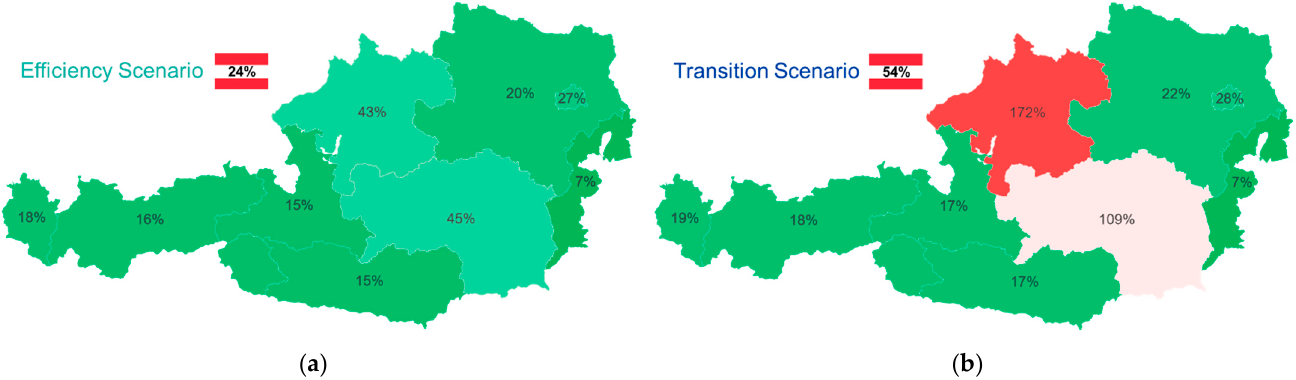
Figure 8. Coverage of electrical energy and required renewable energy potential in ( a ) efficiency and ( b ) transition scenario.